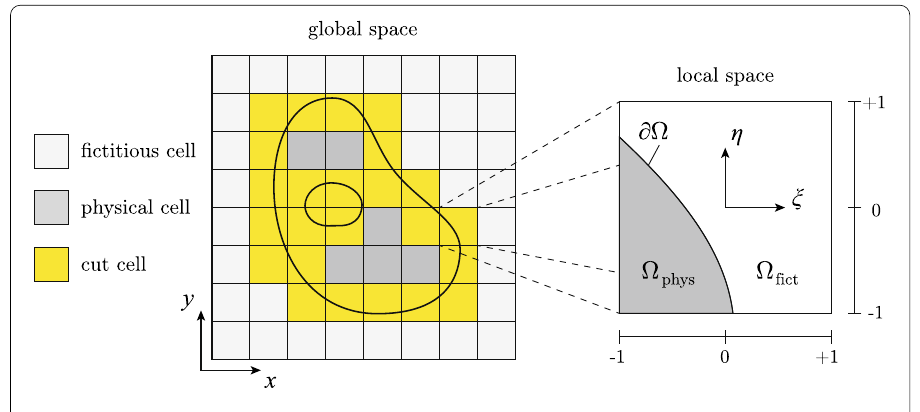
Fig. 6 Different types of sub-cells (left) and a cut cell with its local coordinate system ξ = [ ξ , η ] T